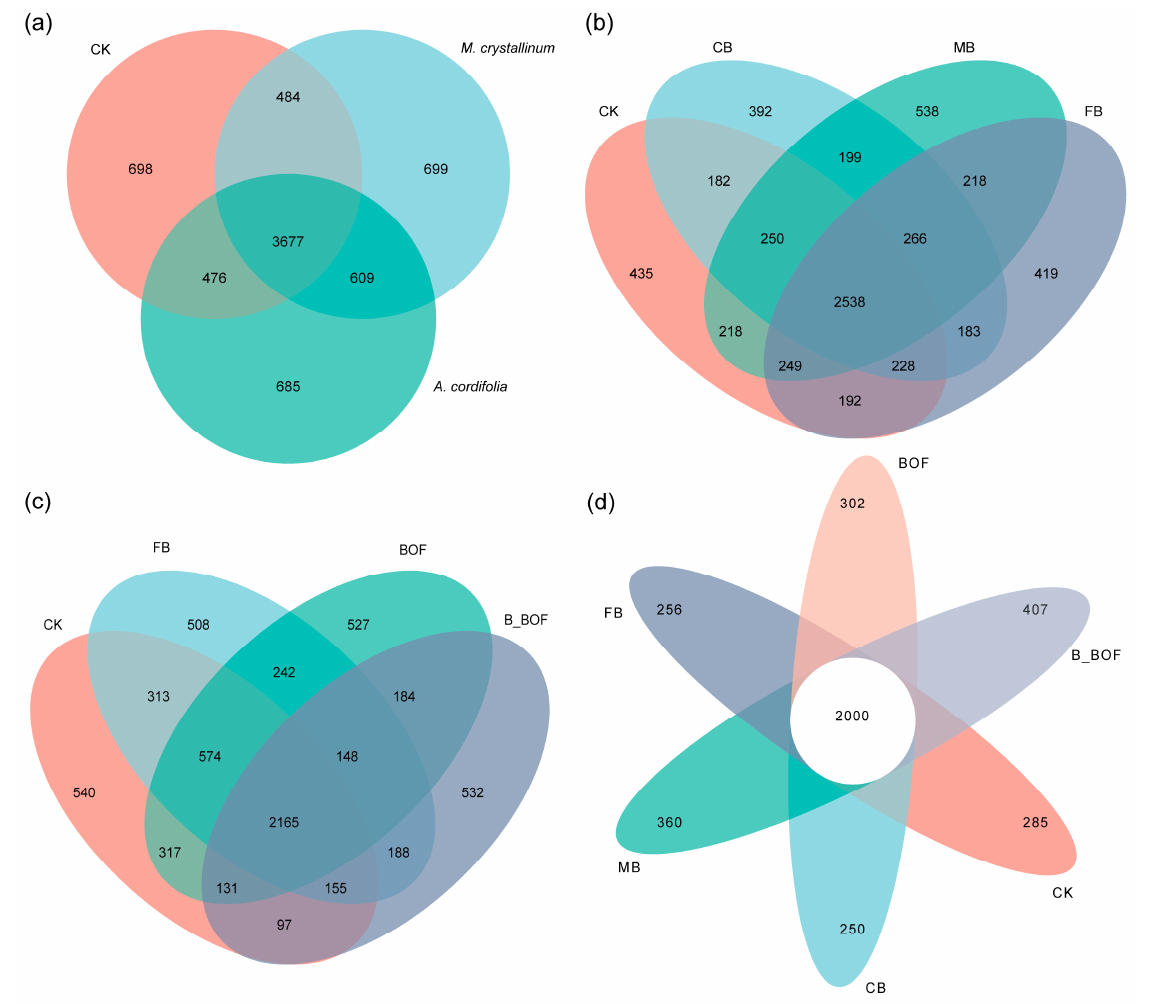
Figure 2. Venn diagrams of the number of OTUs obtained in different treatments. ( a ) Grouping by plants. ( b ) Grouping by different biochar. ( c ) Grouping by combined application of FB and BOF versus independent application. ( d ) Grouping by different treatments of biochar and BOF.